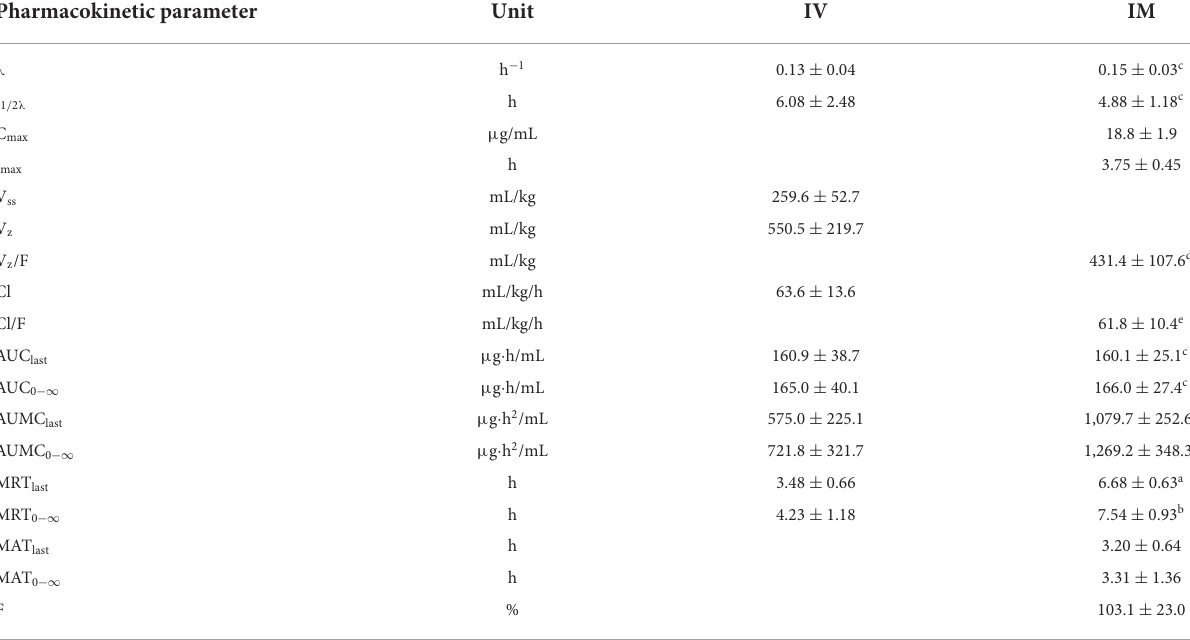
TABLE 1 Non-compartmental pharmacokinetic parameters (mean ± SD) of menbutone obtained after IV and IM administration (10 mg/kg) to 12 sheep. Pharmacokinetic